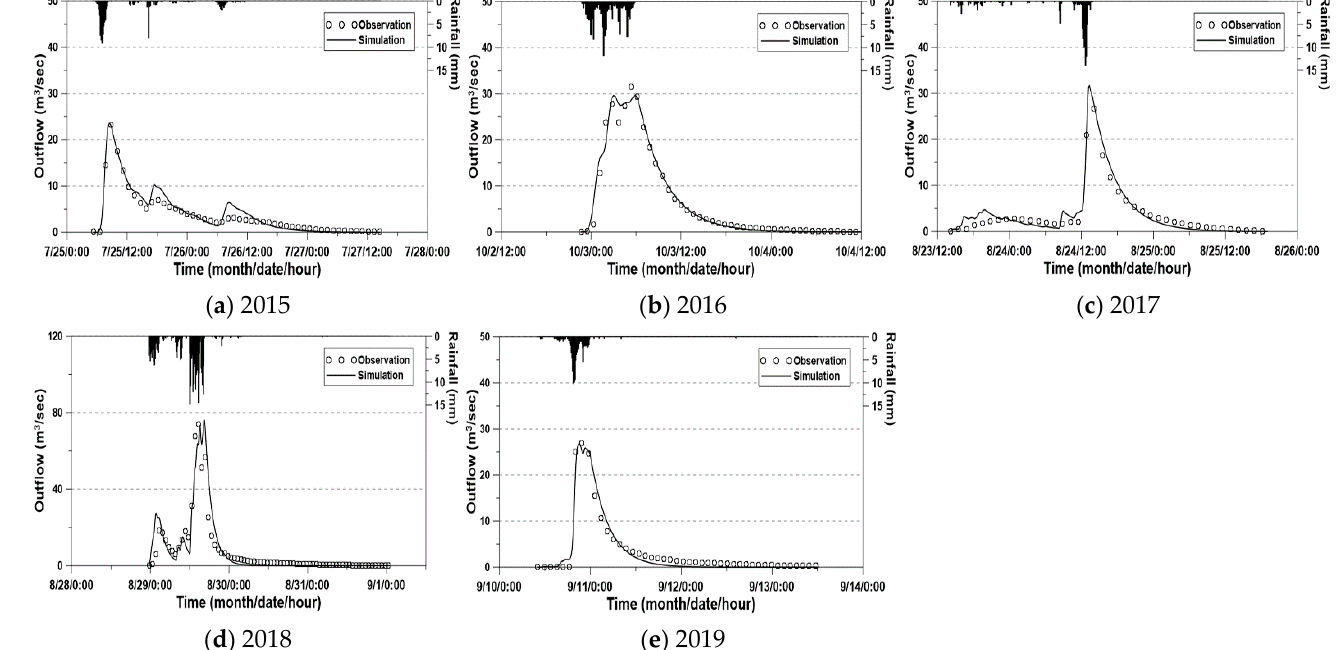
Table 4. Comparison of the uniform velocity case and the different velocity case by the root mean square error (RMSE) and the coefficient of determination (R 2 ) estimated by comparing the simulated runoff hydrographs to the observed.